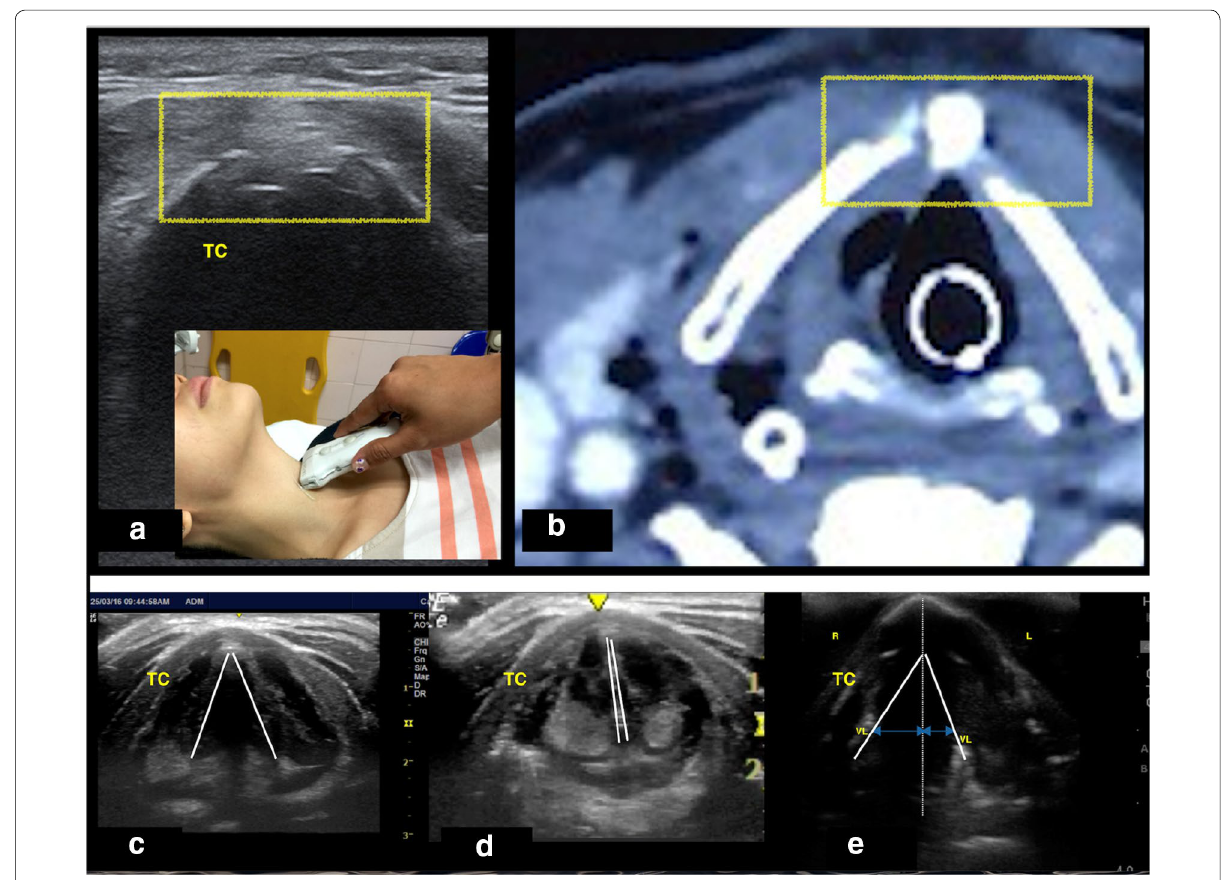
Fig. 3 a Image of focused airway of displaced thyroid cartilage fracture and disruption of anterior cortex of the thyroid cartilage (box). b A computerized tomography (CT) scan image showing defect in posterolateral wall of trachea with fracture of right anterior lamina of thyroid cartilage and superior cornu of left thyroid cartilage. c , d Assessment of vocal cord mobility can be done by looking at the movement of vocal ligament (white line) during abduction and adduction. e Blue arrow indicates reduced movement of the right vocal ligament (white line) to the midline during adduction compare to the left vocal ligament. R: right; L: left; VL: vocal ligament, TC: thyroid cartilage